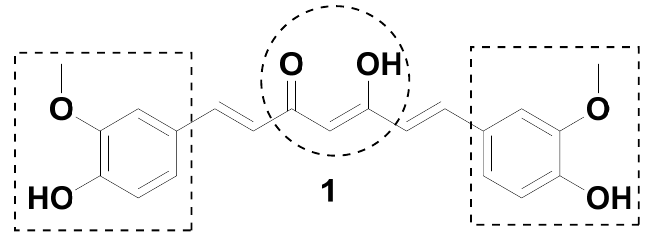
Figure 1. Curcumin and its reactive sites.